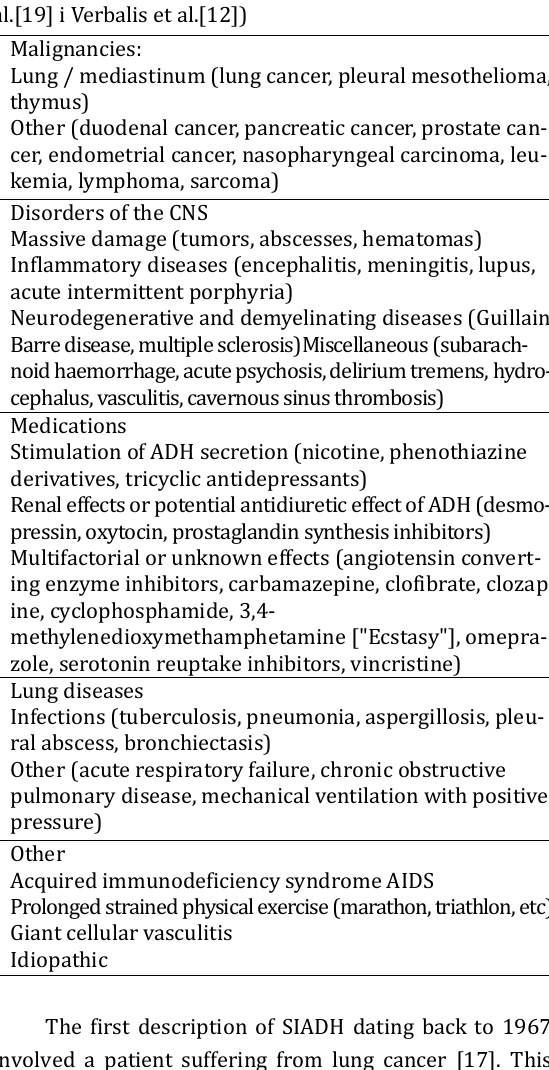
Tabele 5. The causes of SIADH (adapted from: Cuesta